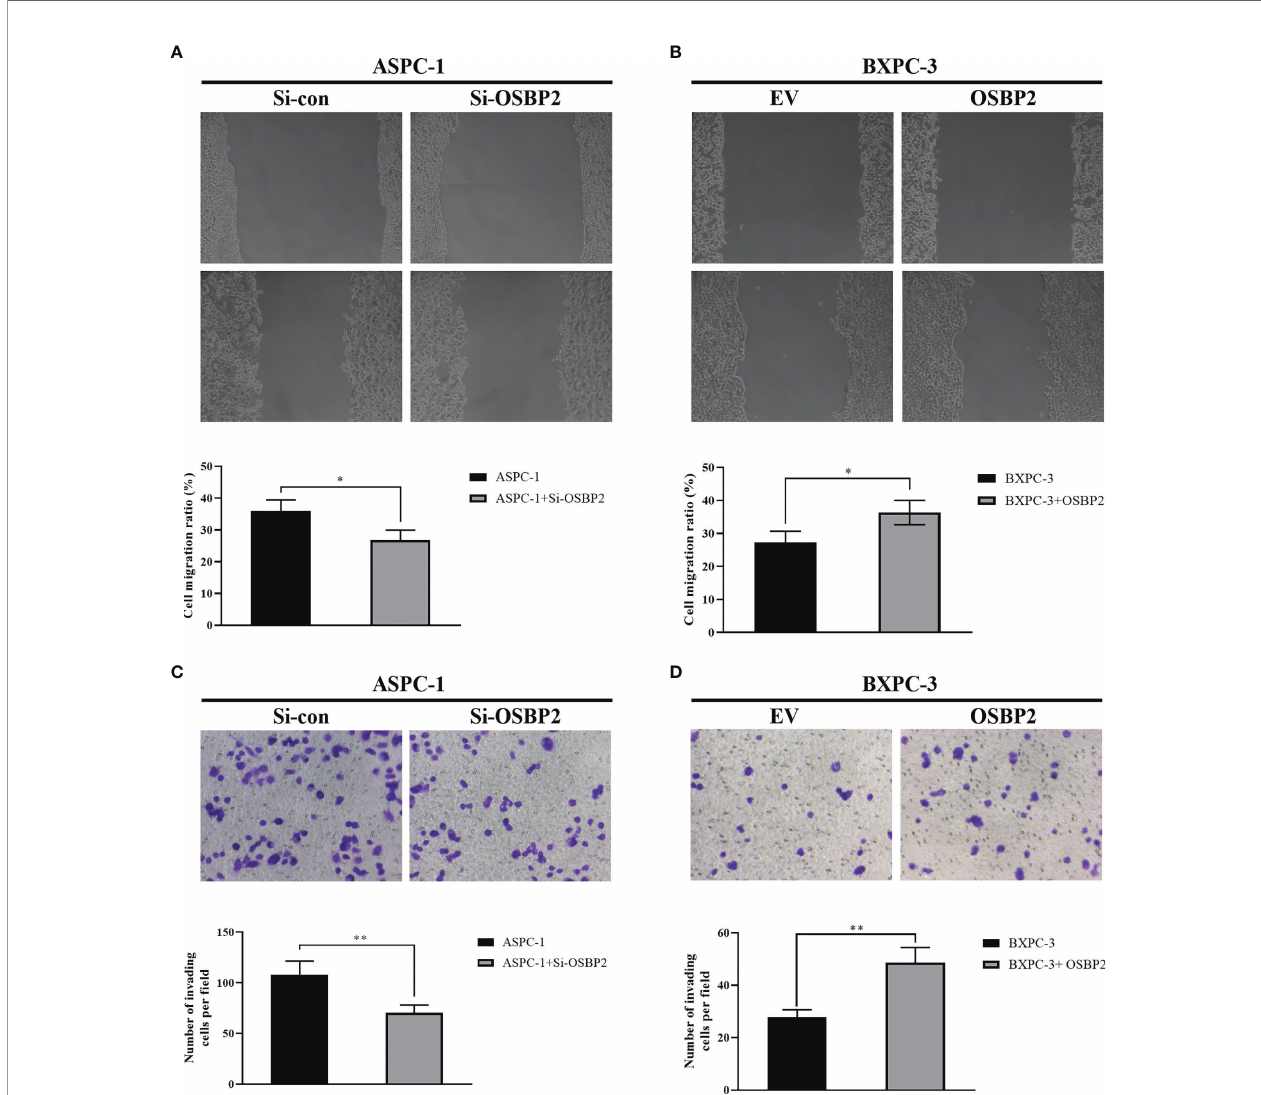
FIGURE 2 | Effect of OSBP2 on PDAC cell migration and invasion. (A) Low OSBP2 expression inhibited ASPC-1 cell migration (P <0.05). (B) Overexpression of OSBP2 promoted BXPC-3 cell migration (P < 0.05). (C) Low OSBP2 expression inhibited ASPC-1 cell invasion (P <0.01). (D) Overexpression of OSBP2 promoted BXPC-3 cell invasion (P <0.01). OSBP2, oxysterol-binding protein 2; PDAC, pancreatic ductal adenocarcinoma; Si-OSBP2, siRNA targeting OSBP2; EV, empty vector. *P < 0.05, **P <